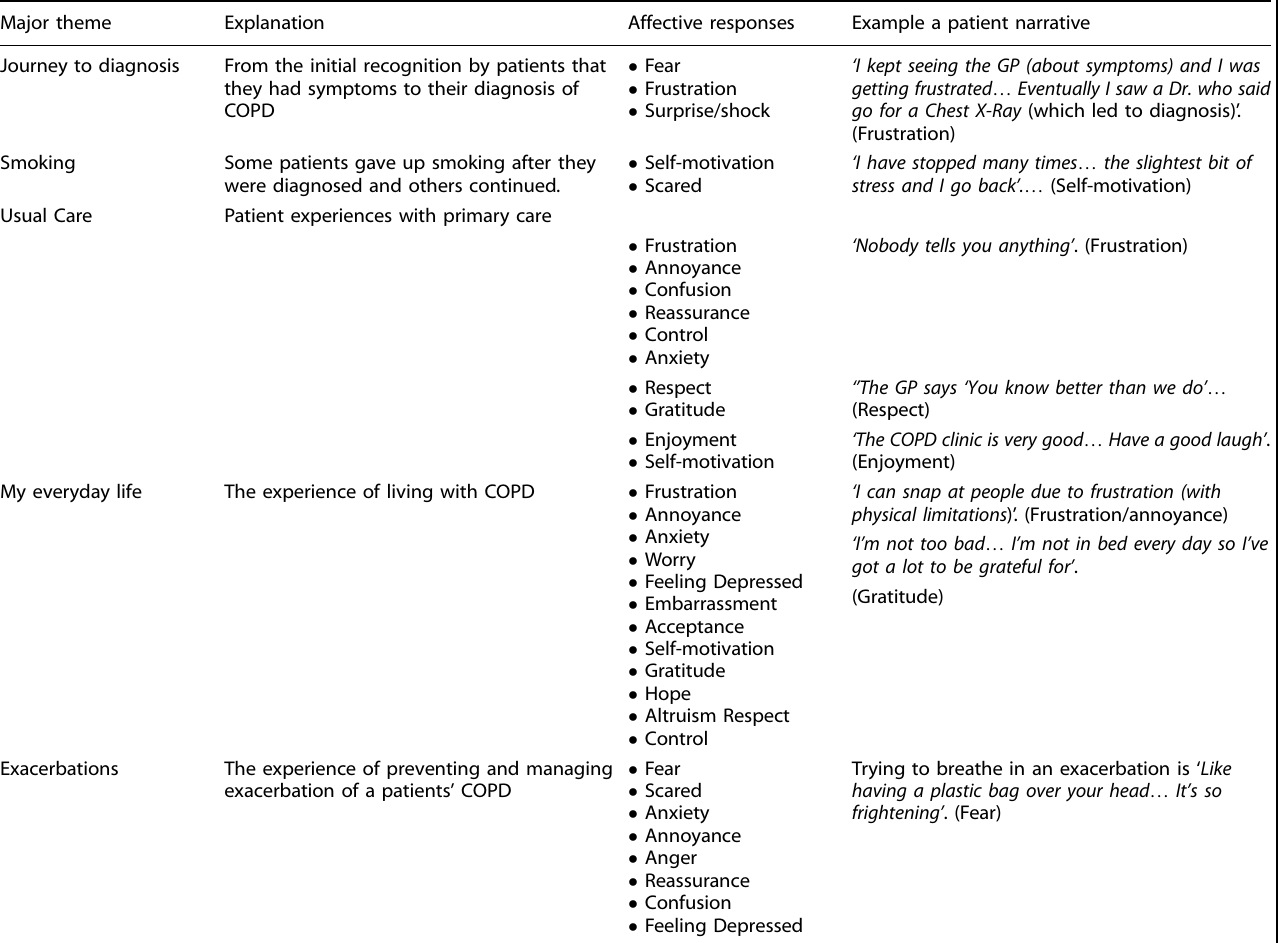
Table 3. Themes affective responses and examples of patient